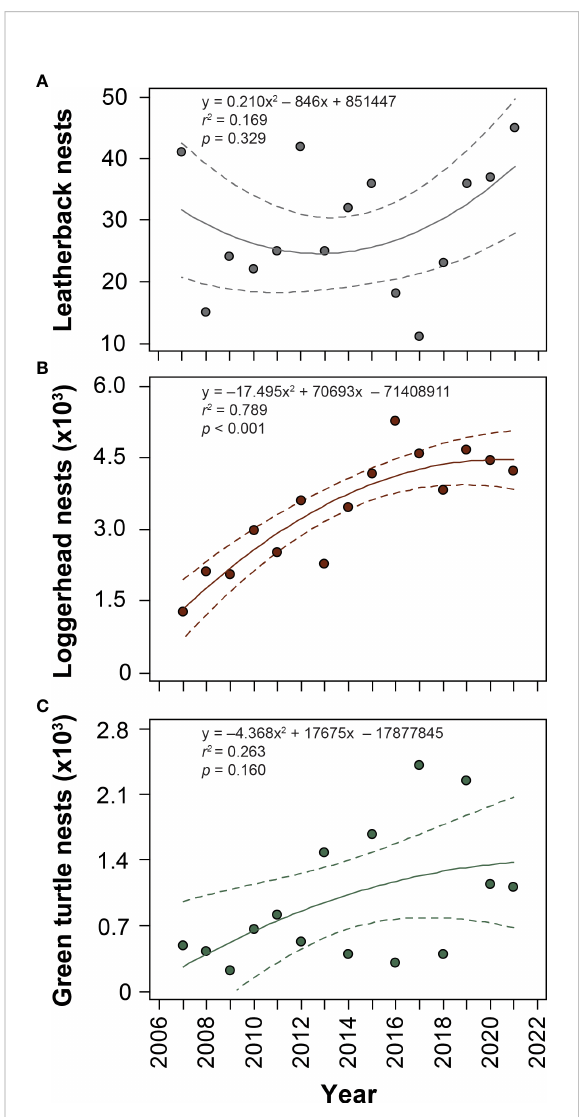
FIGURE 1 Historical nest numbers from 2007 – 2021 for (A) leatherback ( Dermochelys coriacea ), (B) loggerhead ( Caretta caretta ), and (C) green ( Chelonia mydas ) sea turtles on Tequesta, Coral Cove, and Jupiter Inlet Colony Beaches (2.97 km). Results of polynomial regression analyses are shown, with loggerheads showing a signi fi cant increase in nest numbers during the study